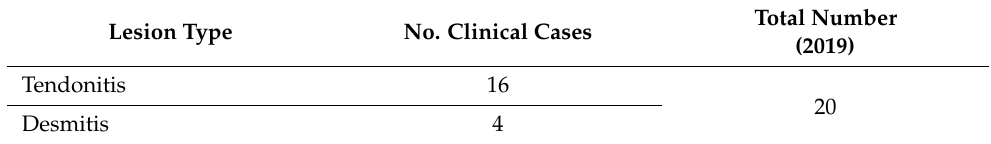
Table 4. Lesion type